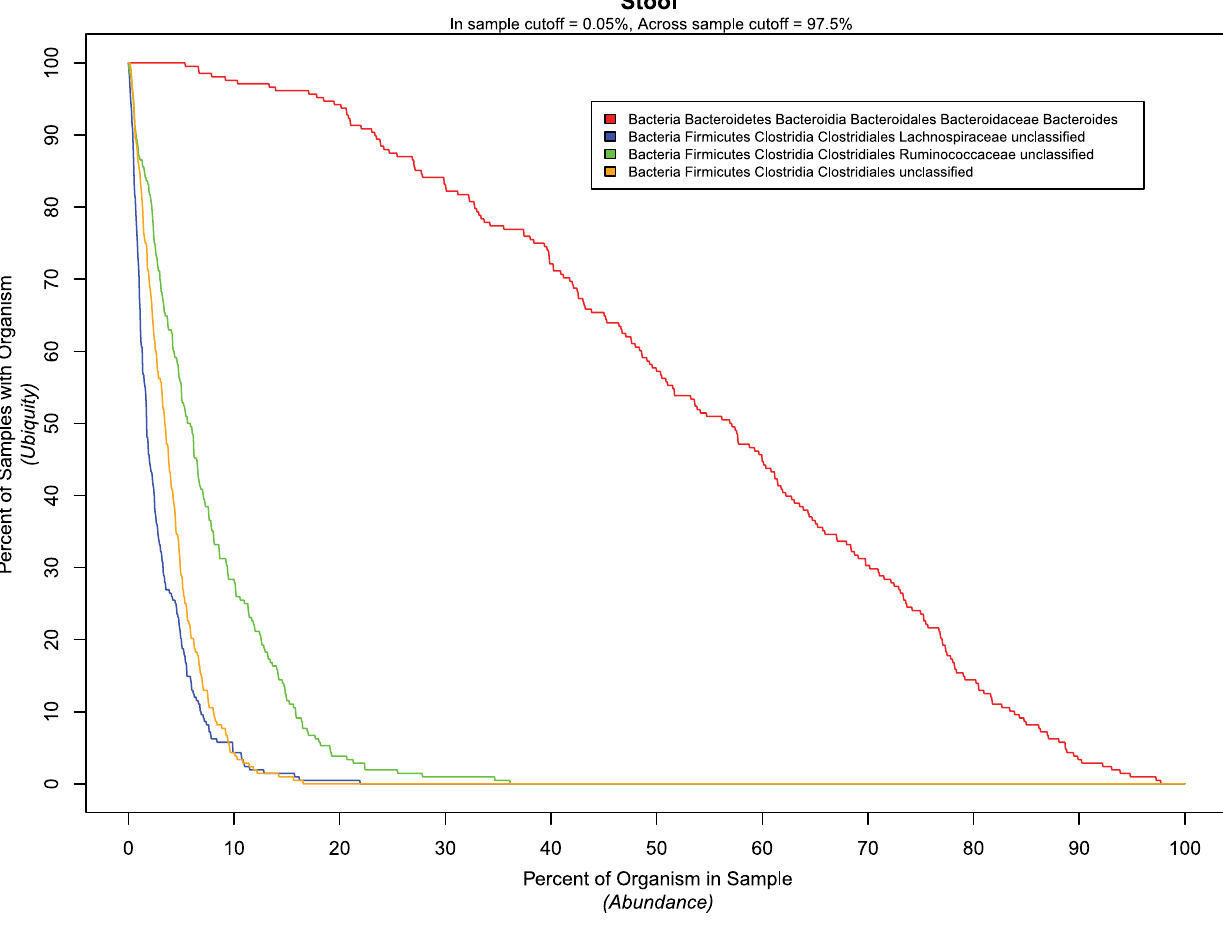
Figure 4. Low abundance, high ubiquity taxa. This figure helps the observer to comprehend the relationship between abundance and ubiquity when defining a core microbiome. As one would expect, increasing the abundance threshold for defining whether a sample contains a particular taxon would reduce the percentage of samples (ubiquity) that would contain it. The lines that are presented refer to all taxa in the stool samples that are in more than 97.5% of the samples with an abundance cutoff of 0.05%. The taxon Bacteroides (red) is both relatively highly abundant and highly ubiquitous, so its fall off is less steep than the Clostridales shown.